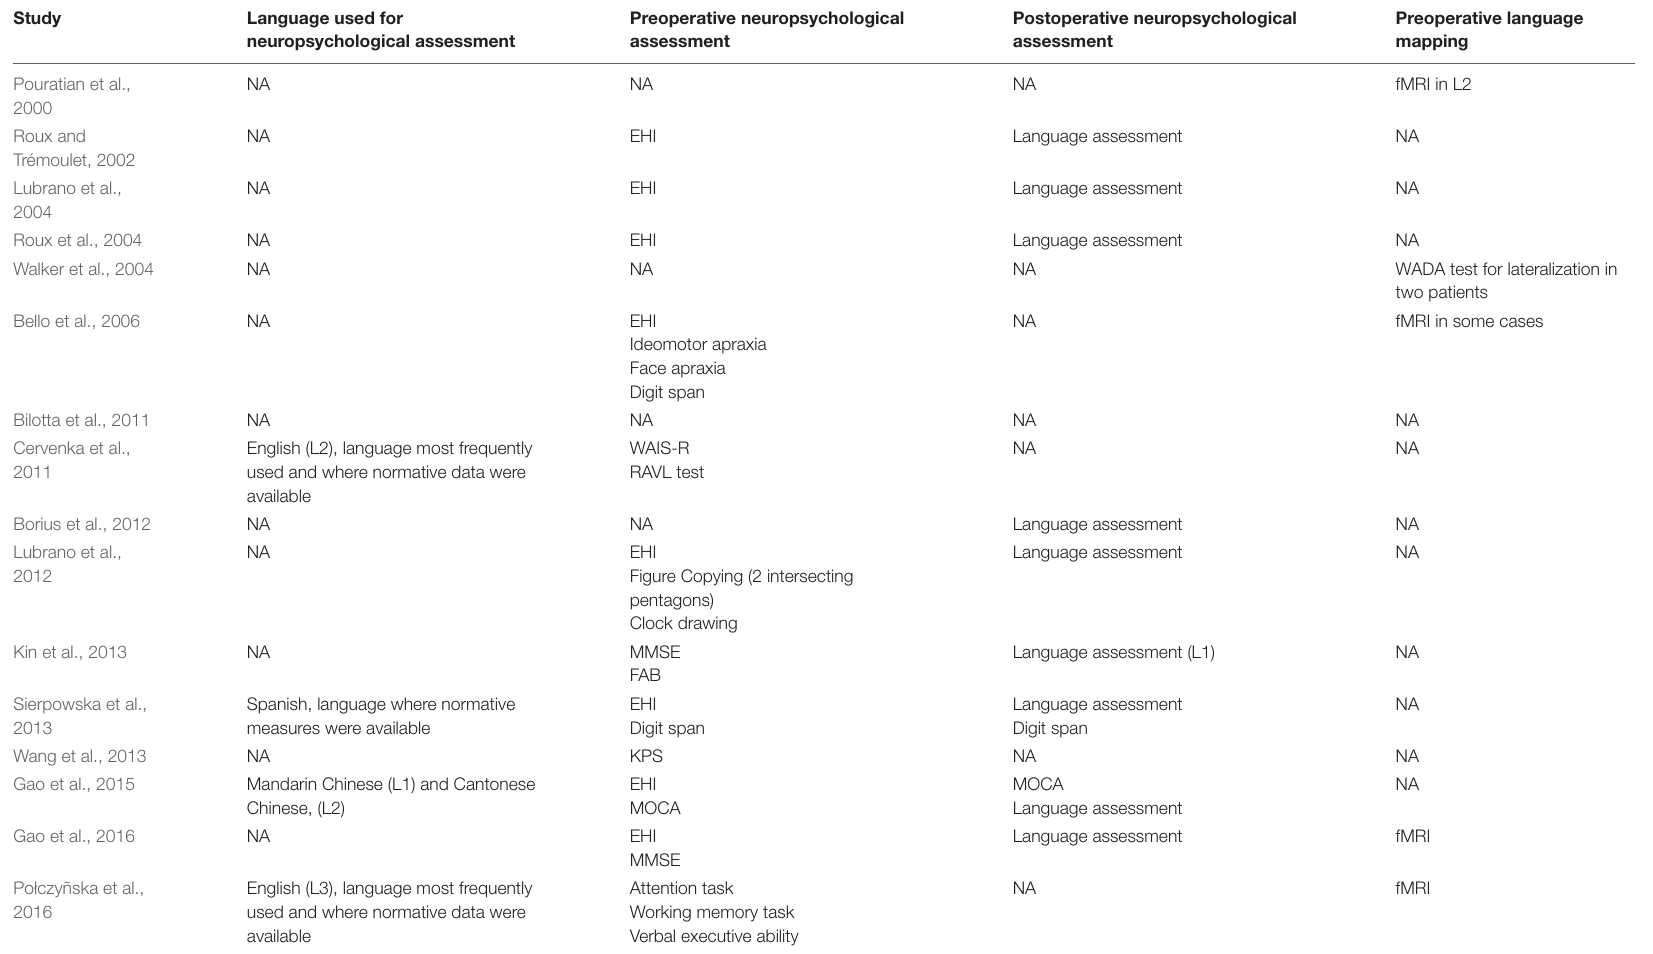
TABLE 6 | Preoperative and postoperative neuropsychological assessment and preoperative language mapping*.